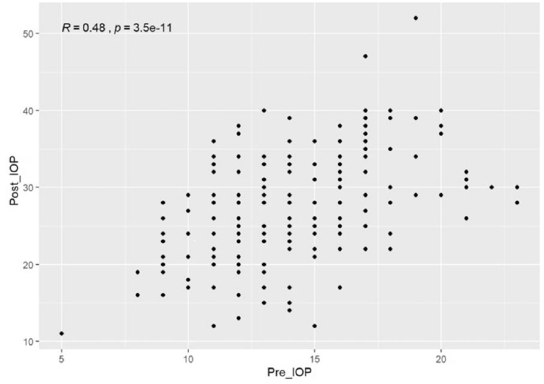
Figure 3. Scatterplot of intraocular pressure (IOP) pre- and post-treatment. Pearson correlation is shown in the upper left corner. Post IOP intraocular pressure after injection, Pre IOP intraocular pressure before injection.